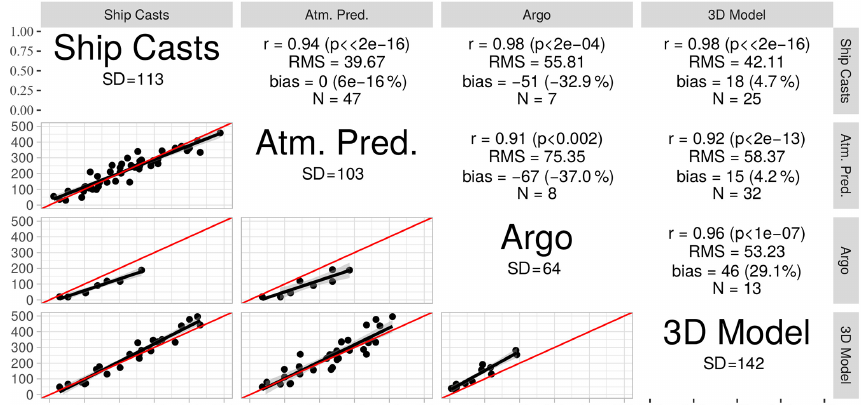
Figure A1. Statistics of comparison between the different data sources: Pearson correlation coefficient ( r ), root-mean-square deviation (RMS), average bias (bias); number of overlapping years between time series ( N ) and, on diagonal elements, the standard deviation of each time series (SD).